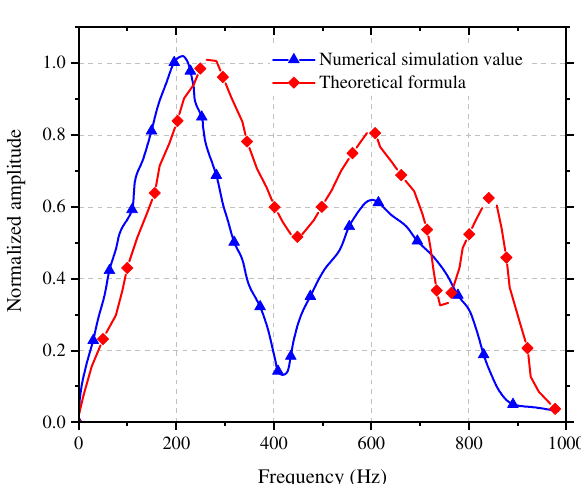
Figure 17. Comparing the measured results and numerical calculation results.